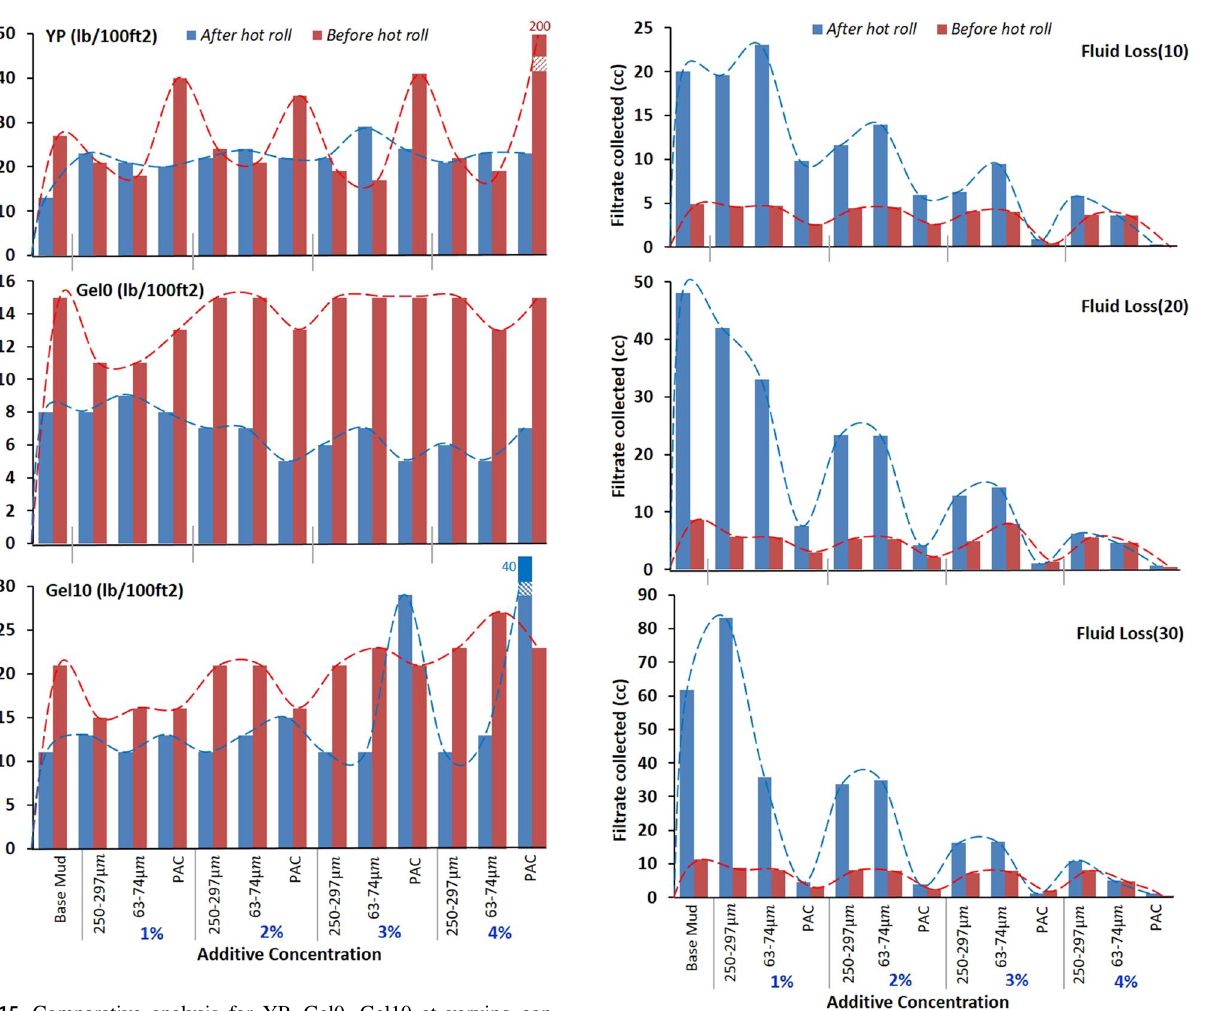
Fig. 16 A graphical interpretation illustrating the API filtration losses as a function of time at 10, 20, and 30 min before and after hot roll. Incredibly large variations can be seen between before and after hot roll readings, particularly at 1–2% concentrations